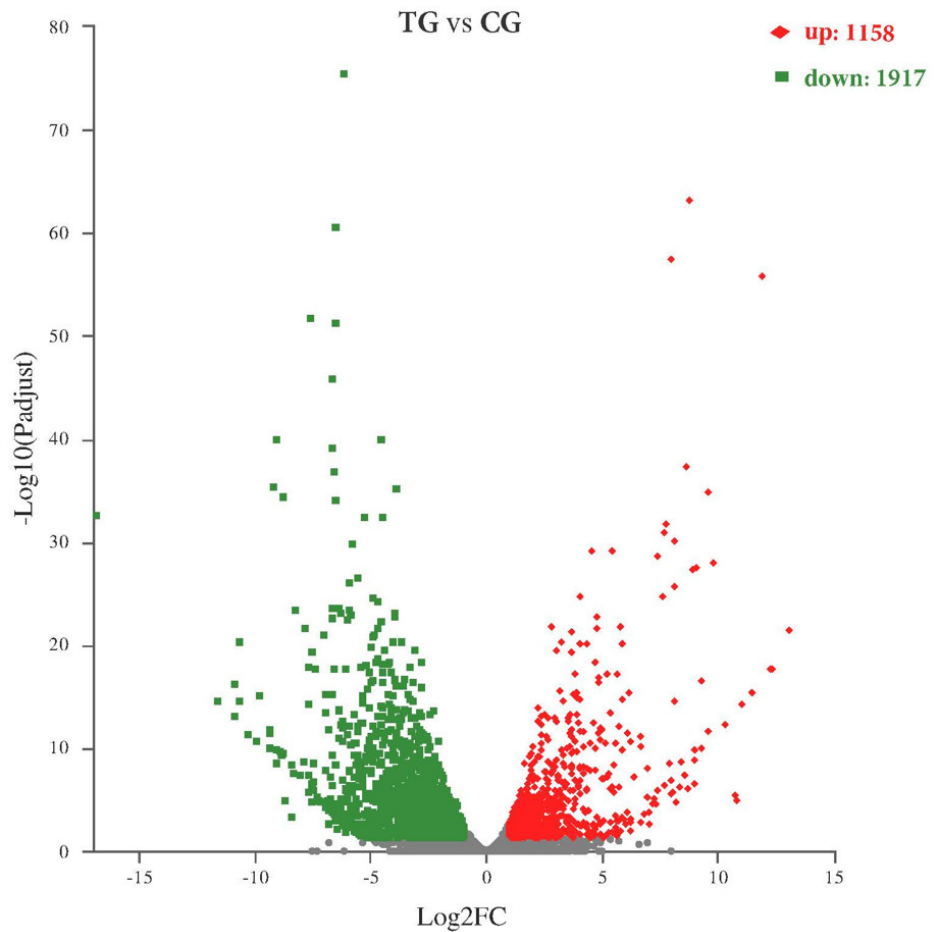
Figure 4. Volcano plot of DEGs between the treated group (TG) and the control group (CG). The y-axis corresponds to the mean expression value of log10 ( p -value), and the x-axis displays the log2 fold change value. Grey dots: non-differential expressed genes. Red dots: up-regulated genes. Green dots: downregulated genes.